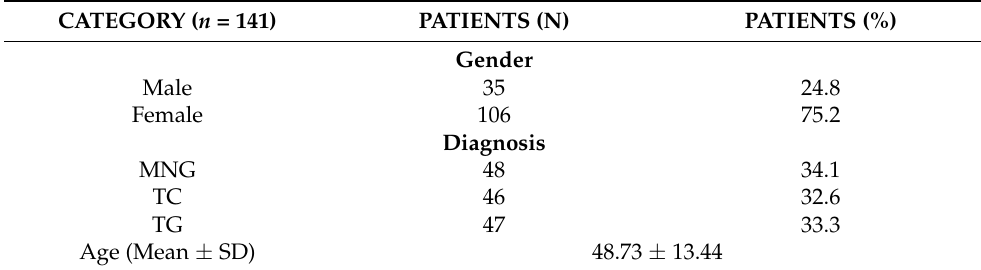
Table 1. Patient